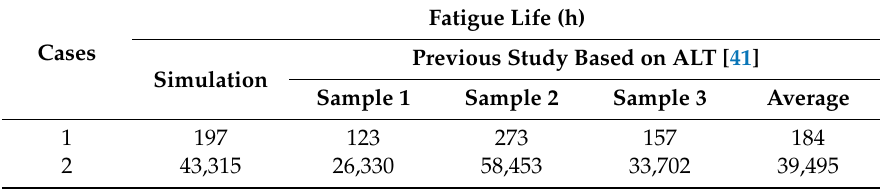
Figure 11. Comparison between fatigue life analysis results by simulation and obtained fatigue life from a previous study with three samples for each load condition: ( a ) case 1 and ( b ) case 2. Table 8. Fatigue life of spiral bevel gear, according to the simulation results and a previous study based on ALT.